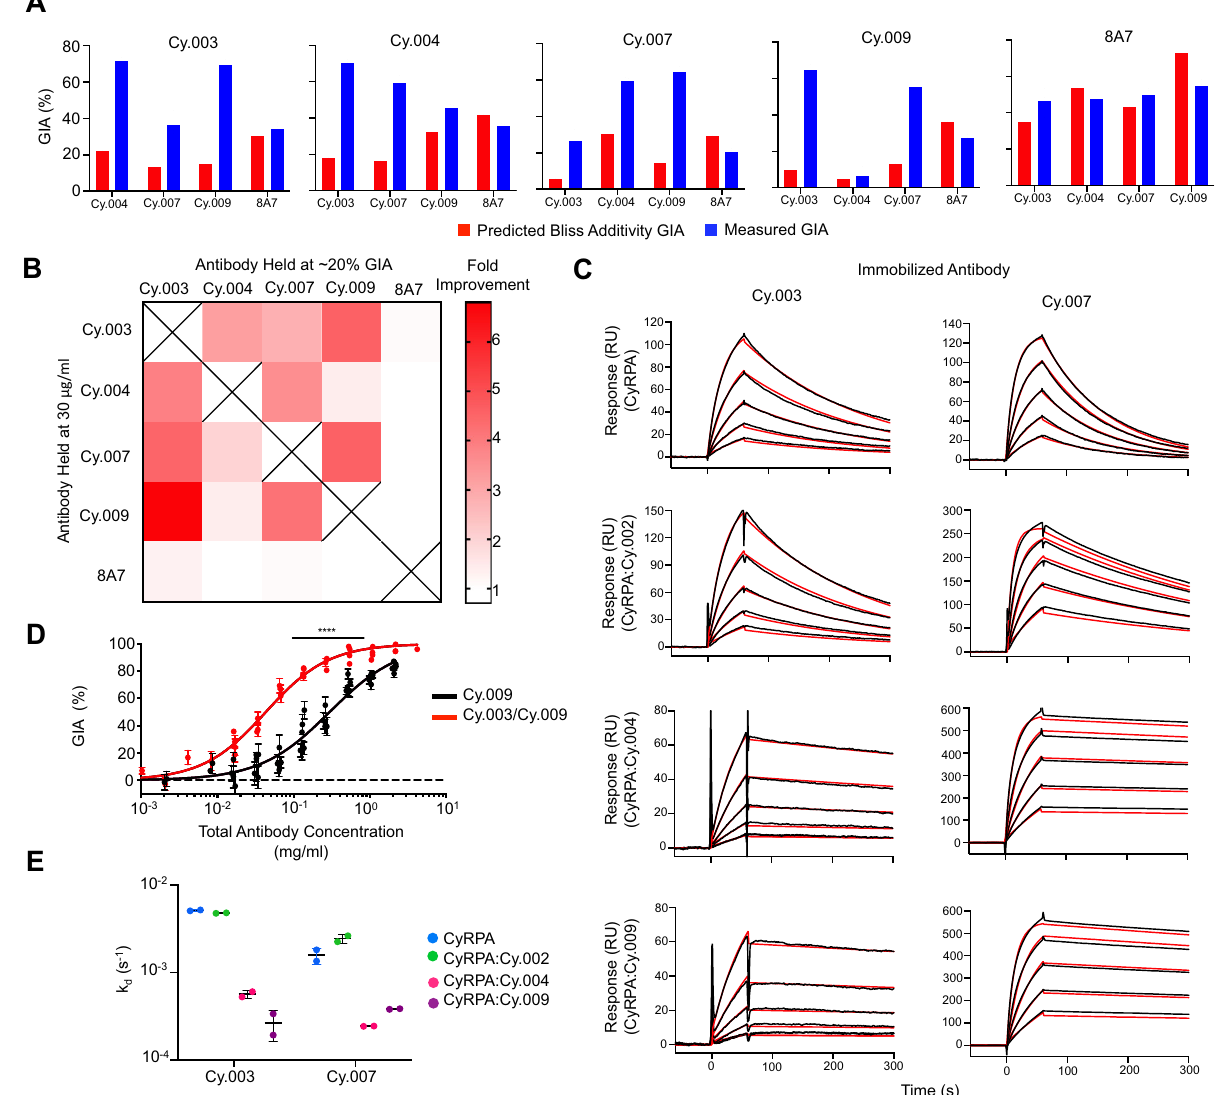
Fig. 5 Demonstration of synergistic growth inhibitory activity of monoclonal antibodies targeting CyRPA. A Predicted growth inhibitory activity (GIA) based on Bliss additivity (red) compared to measured GIA in blue for a mAb combination where one was held at 30 μ g/ml (title) and the other held at 20% GIA ( X -axis). Complete dilution curves can be seen in Supplementary Fig. 4A. Combinations were measured twice with a single representative experiment shown here. Bar indicates the mean across triplicate measurements. B Heat map summary of the fold improvement over Bliss additivity from panel ( A ). C SPR sensorgrams of Cy.003 and Cy.007 binding to CyRPA and Fab:CyRPA complexes of Cy.002, Cy.004, or Cy.009 in TBS with 1 mM CaCl 2 . The black lines indicate the measured response while red lines indicate the curve fi t. Each graph shows a fi ve-step two-fold dilution curve starting from 500 nM. D GIA of Cy.009 compared to that of a Cy.003/Cy.009 1:1 mixture (i.e., 1 mg/ml = 1 mg/ml Cy.009 or 0.5 mg/ml Cy.009 + 0.5 mg/ml Cy.003). Each individual point is the mean of a triplicate measurement with error bars indicating the standard deviation. n = 5 and n = 6 independent experiments of complete dilution curves for Cy.009 and Cy.003/Cy.009 respectively. Curve fi t used a four-parameter dose-response curve with the upper bound constrained to 100% GIA. EC 50 shift determined through extra-sum-of-squares F test ( F = 77.68, DFn = 1, DFd = 80), p < 0.0001. E Summary of changes in dissociation rate constant ( k d ) for SPR data shown in ( C ). Horizontal line indicates the mean and error bars show the standard deviation across n = 2 independent